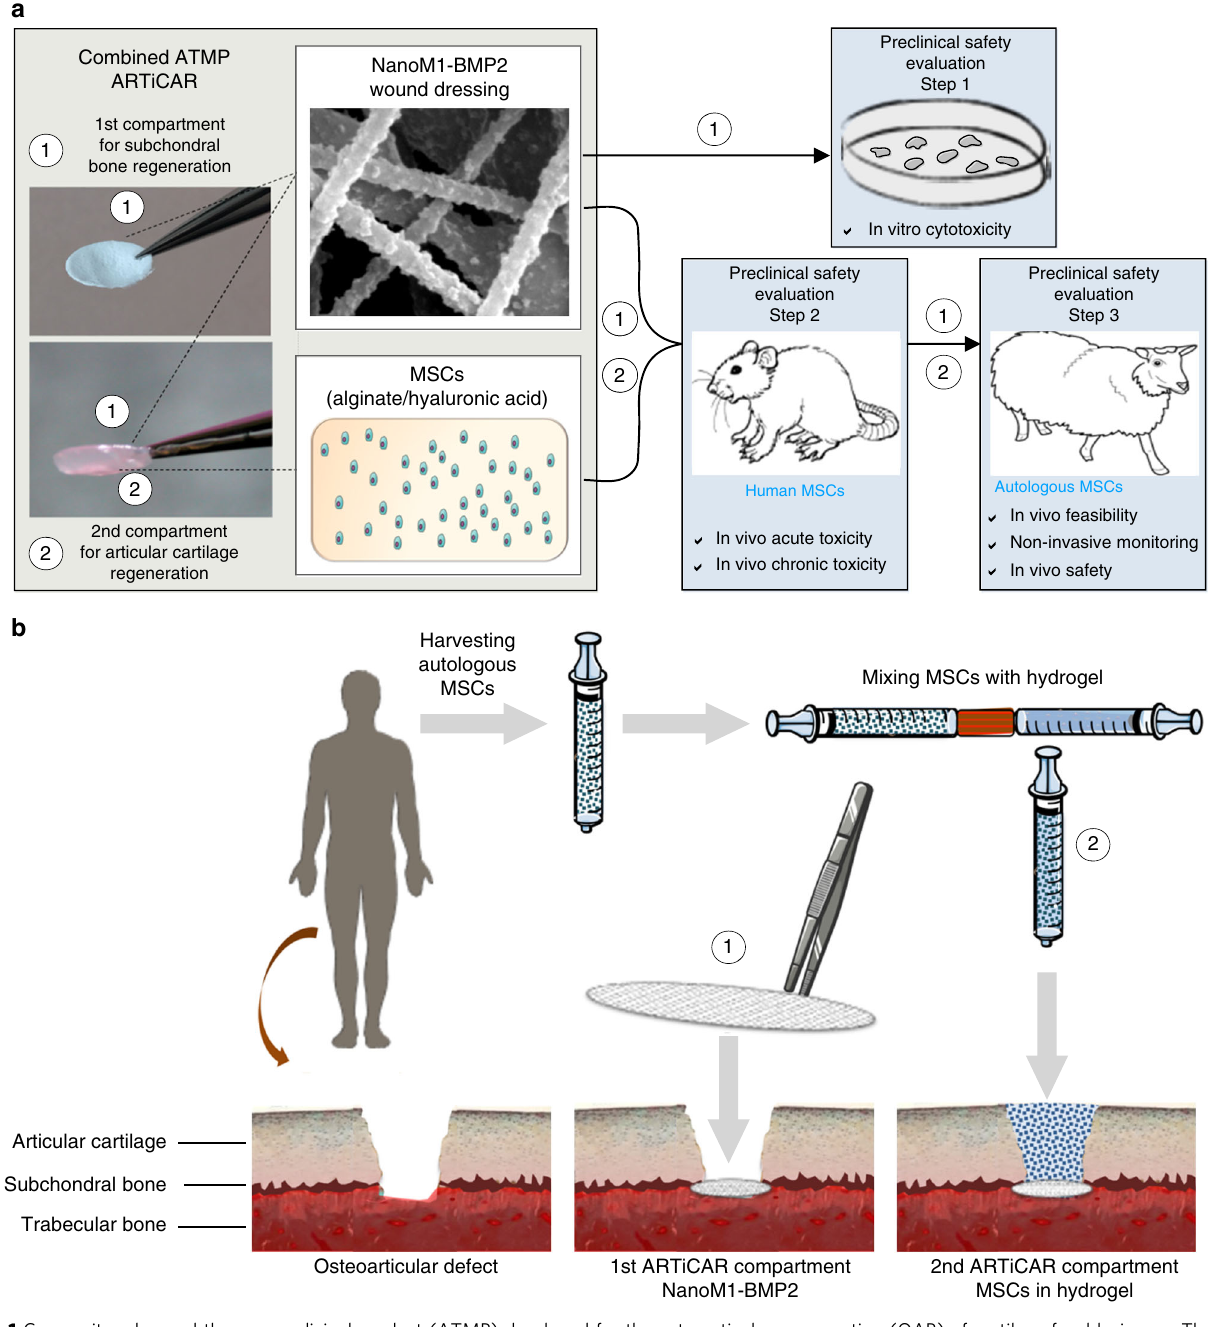
assess the feasibility of its usage in large animals, osteoarticular defects were induced in femoral condyles of adult sheep and were either left un fi lled (no-treatment control: NT) of fi lled with the ARTiCAR implant or with an autograft (AG), as for supplemental table 1. The healing process was monitored non-invasively